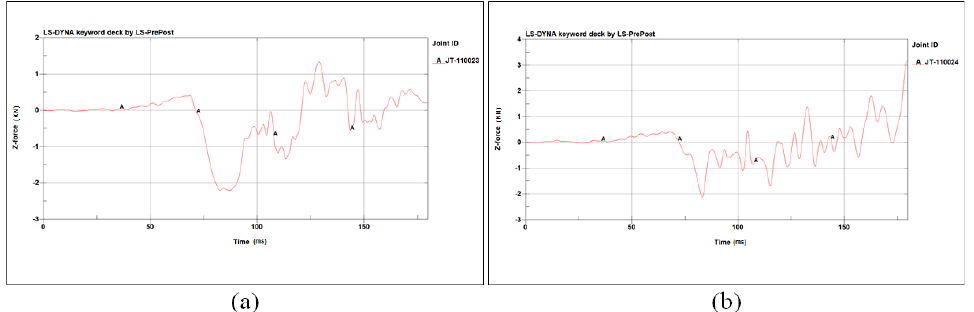
Figure 16. Test 3: HIC curve of ( a ) Dummy 1, ( b ) Dummy 2 and ( c ) Dummy 3.